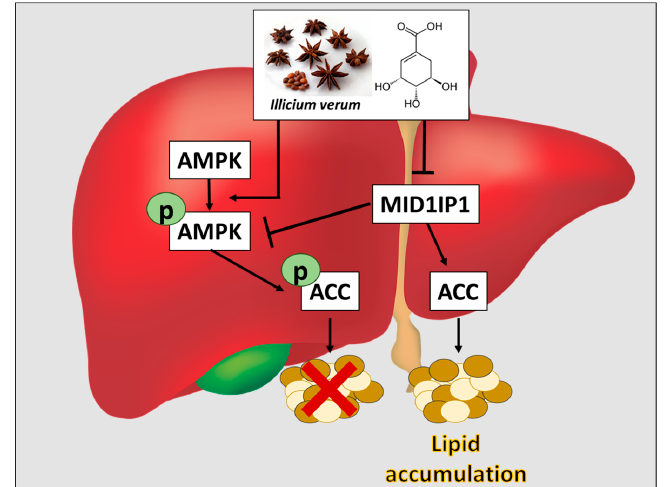
Figure 6. Schematic diagram of hypolipogenic mechanism of shikimic acid via inhibition of MID1IP1 and phosphorylation of AMPK/ACC in hepatocellular carcinomas (HCCs). Black arrow for activation and T bar for